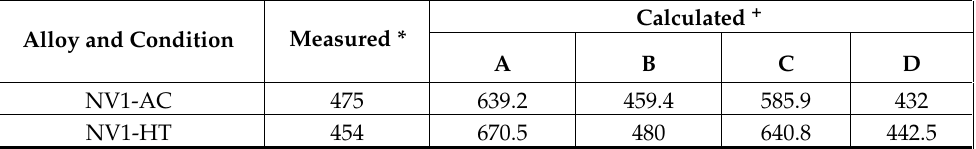
Table 9. Measured and calculated Vickers hardness of